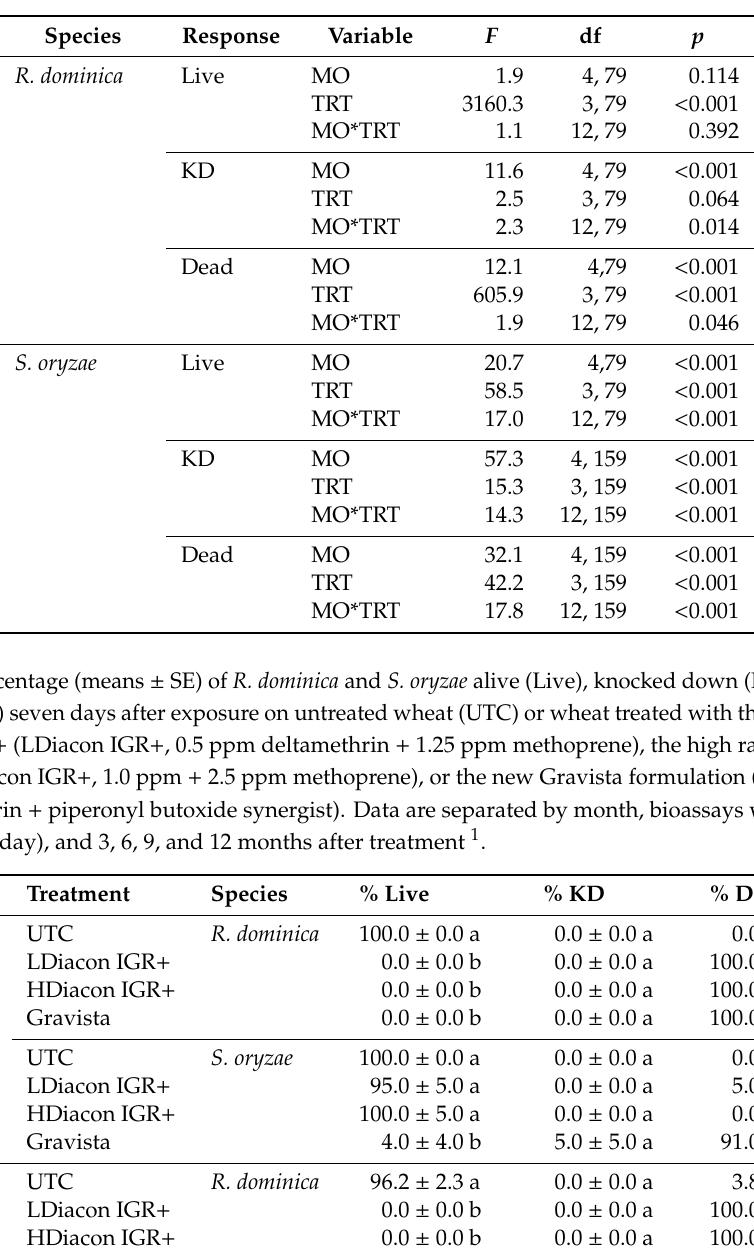
Table 1. ANOVA Table for main e ff ects month (MO), treatment (TR, untreated controls, the low and high rates of Diacon IGR + , and the Gravista formulation) for the percentage (means ± SE) of adult R. dominica and S. oryae that were alive (Live), knocked down (KD), or dead (D) after 7 days of exposure on treated wheat.